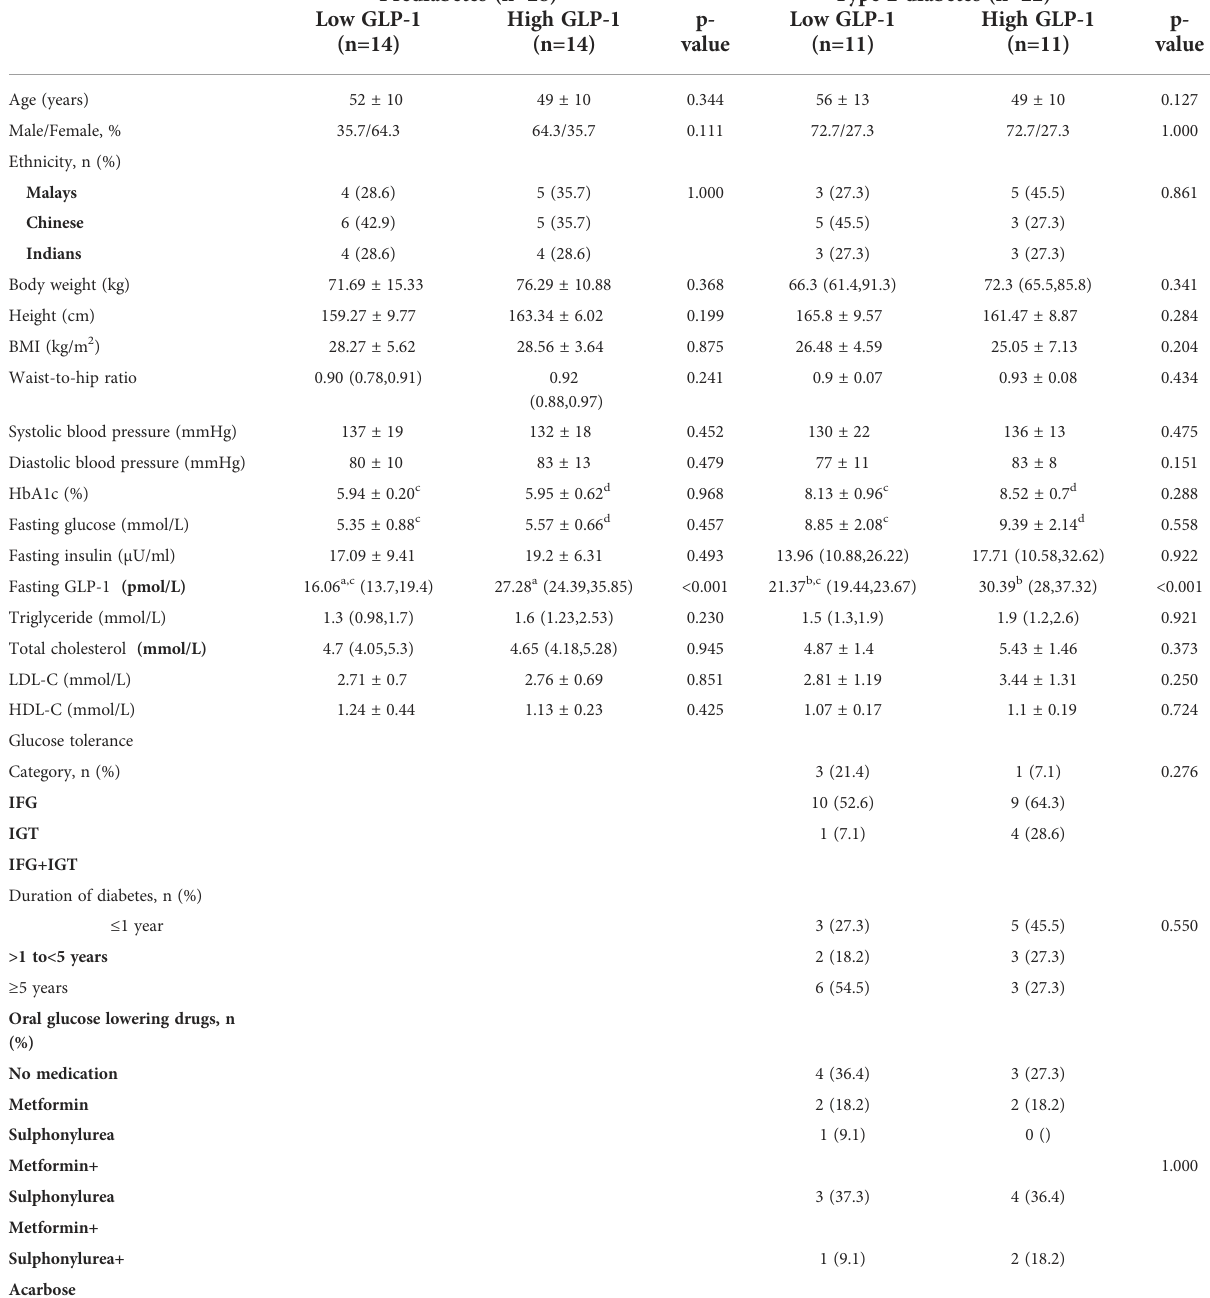
TABLE 2 Baseline demography and clinical characteristics of low versus high GLP-1 levels in prediabetes and type 2 diabetes subjects. Prediabetes